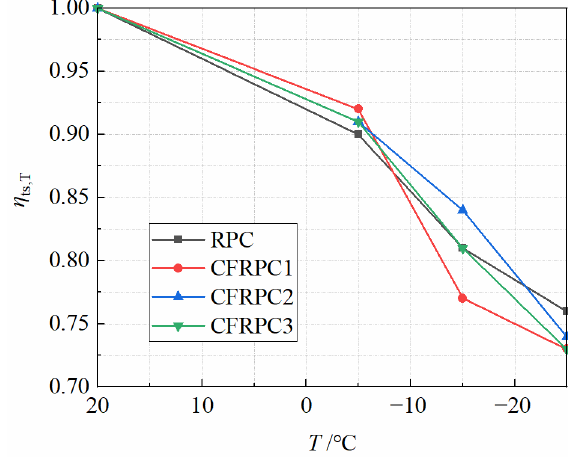
Figure 16. Relationship f ts vs. T.